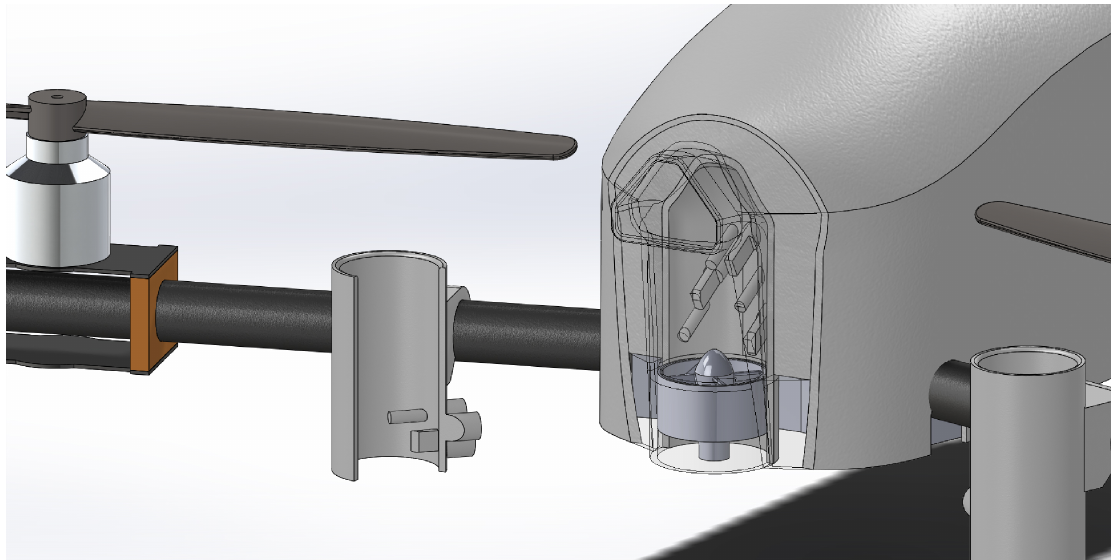
Figure 2. 3D model cross-section of the OU CopterSonde rwUAS highlighting the dual configuration sensor placements. This perspective highlights the location of the individual sensors inside the cylindrical plastic solar shields under the propellers (AP) and the ducted fan on the front of the main body